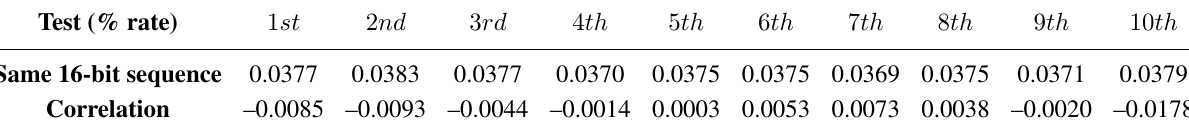
Table 3. EPC Gen2 second and third randomness property